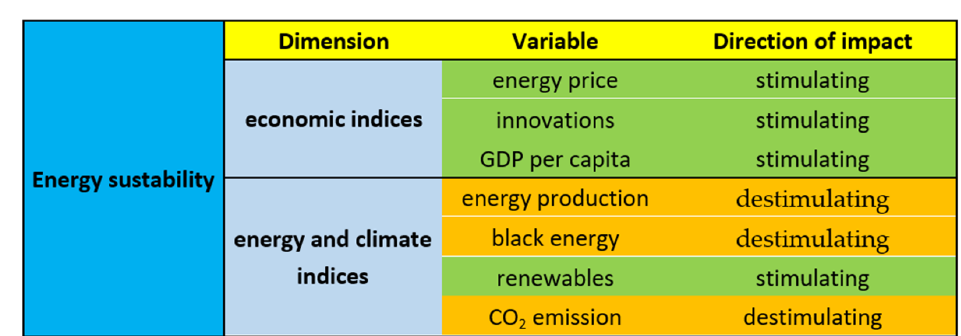
Figure 4. Dimensions of energy sustainability and corresponding variables (green = stimulating, orange = de-stimulating).